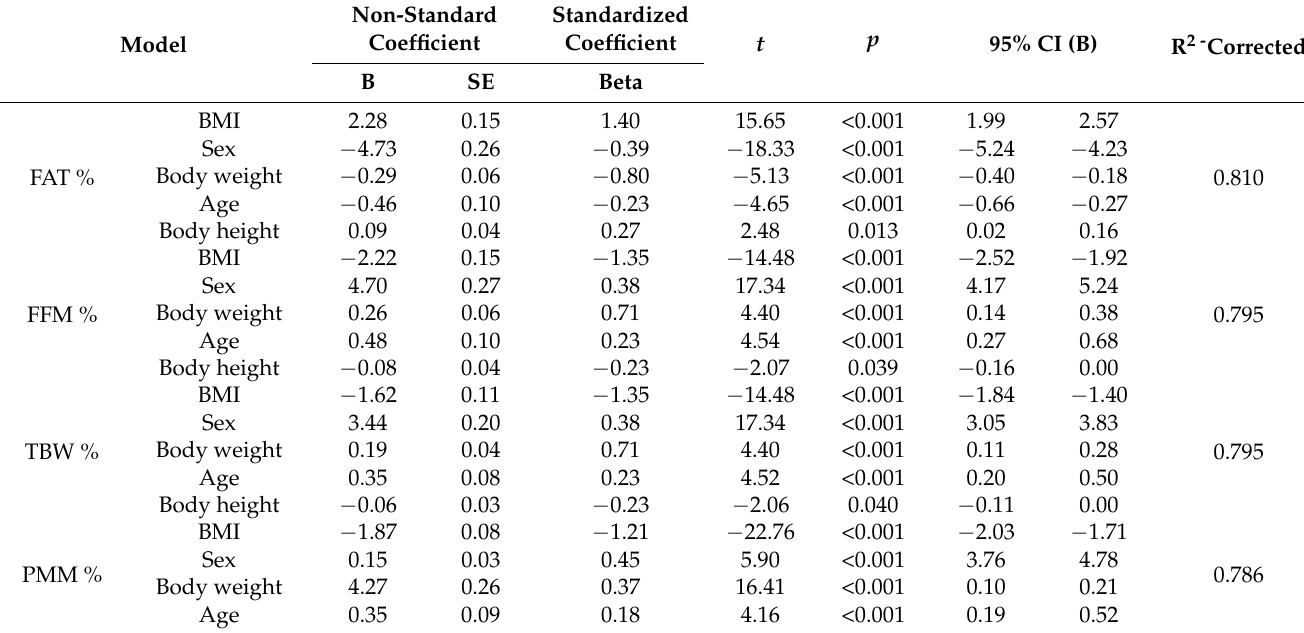
Table 4. Regression of factors influencing the parameters of body mass composition in children.